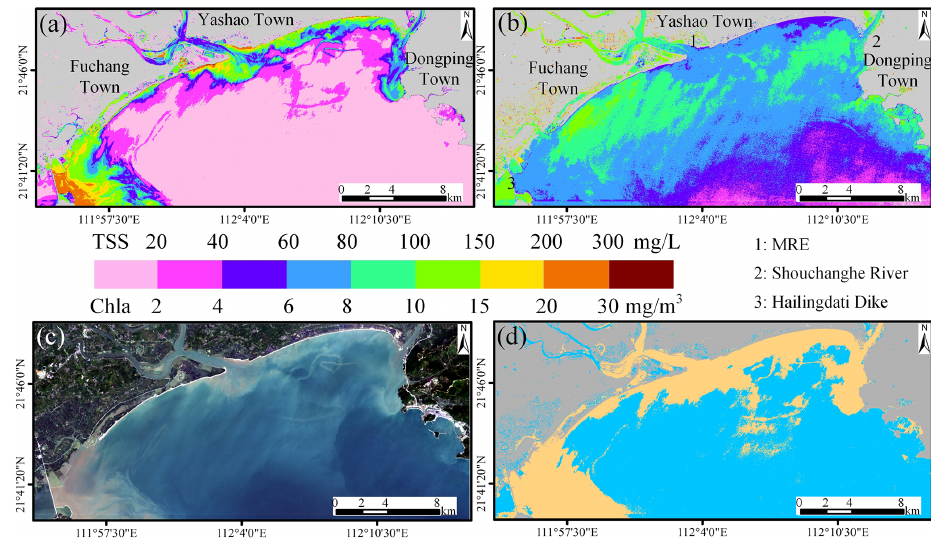
Figure 10. The estimated TSS concentrations (a) , Chl a concentrations (b) , true color imagery (USGS, 1982; NASA, 2001) (c) , and extracted TMZ results, indicated by mango coloring, (d) in the MRE on 6 December 2013 (Low-flow